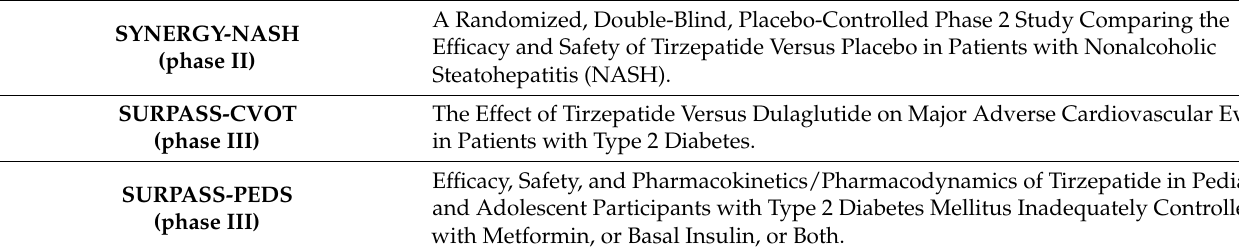
Table 8. Ongoing clinical trials testing